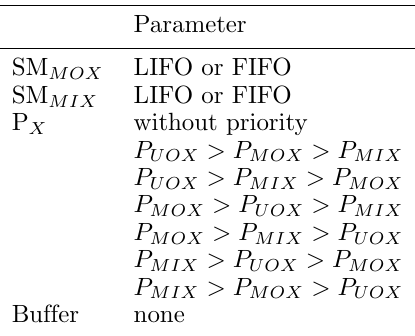
Fig. 7. Schematic representation of fuel cycle facilities; FP, CP and SP stands respectively for Fabrication Plants, Cooling Pools and Separation Plants, SUOX, SMOX and SMIX stands for Storage of different spent fuel type (respectively UOX, MOX and MIX. Finally SRU and SDU stands respectively for Stock of Reprocessed Uranium and Stock of Depleted Uranium. Table 5. Sampled variables for the reference trajectories.